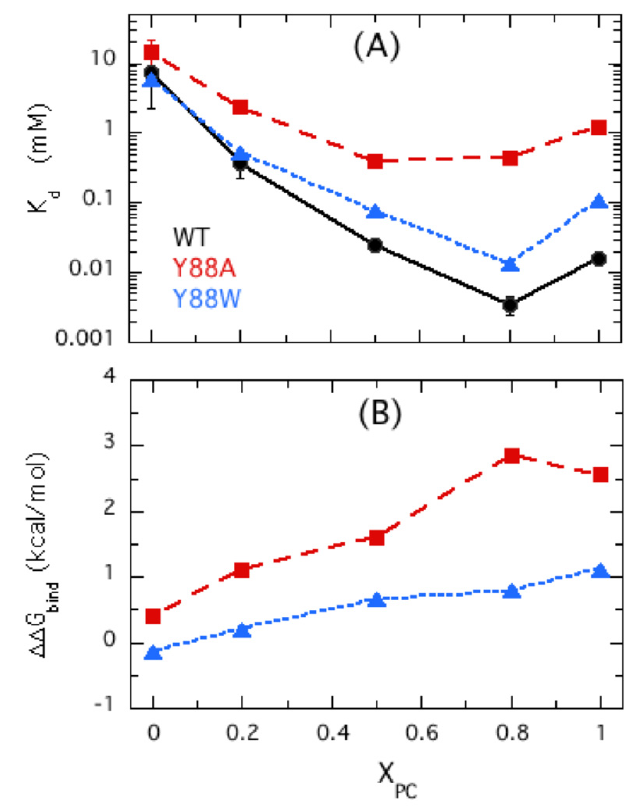
Figure 8. Effect of Tyr88 mutations on the K d for binding to DOPMe/POPC SUVs and the change in ∆∆ G 0 caused by the mutation. ( A ) Apparent K d values determined for unmutated BtPI-PLC (WT circles), Y88A (squares), and Y88W (triangles) as a function of X PC . ( B ) The change in binding free energy relative to wild-type BtPI-PLC caused by the mutation as a function of X PC .